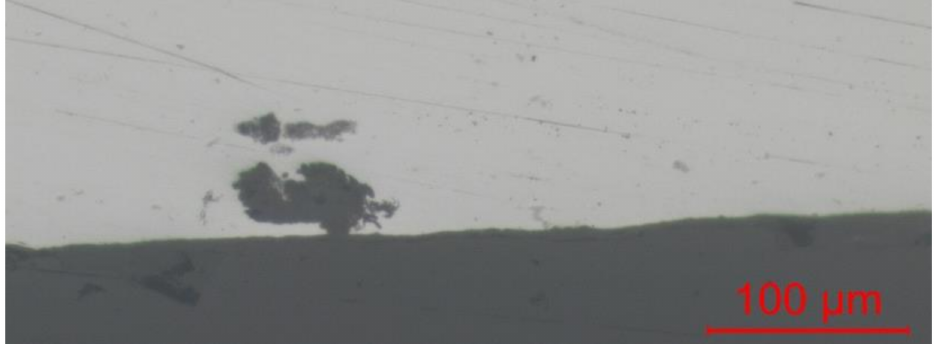
Figure 1. Pitting corrosion observed on AA 2050